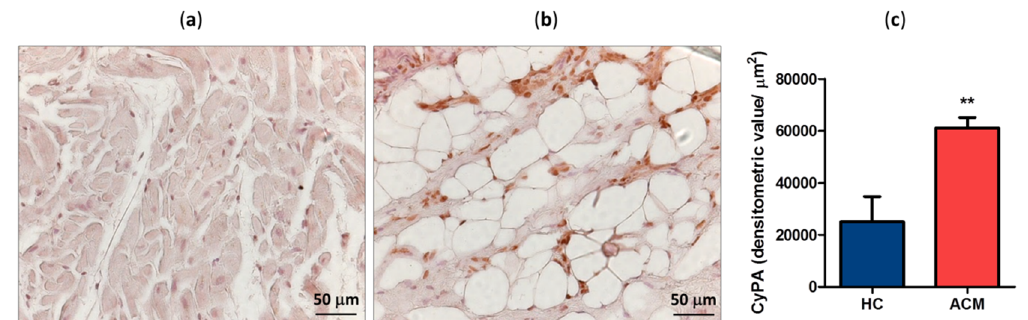
Figure 1. Representative cyclophilin A (CyPA) immunostaining of healthy control (HC) ( a ) and arrhythmogenic cardiomyopathy (ACM) patient ( b ) right ventricle (RV) sections. Positive signal stained brown. Quantification of CyPA expression level in HC and ACM RV tissues ( c ). ** p value ≤ 0.01 at Student’s T test.